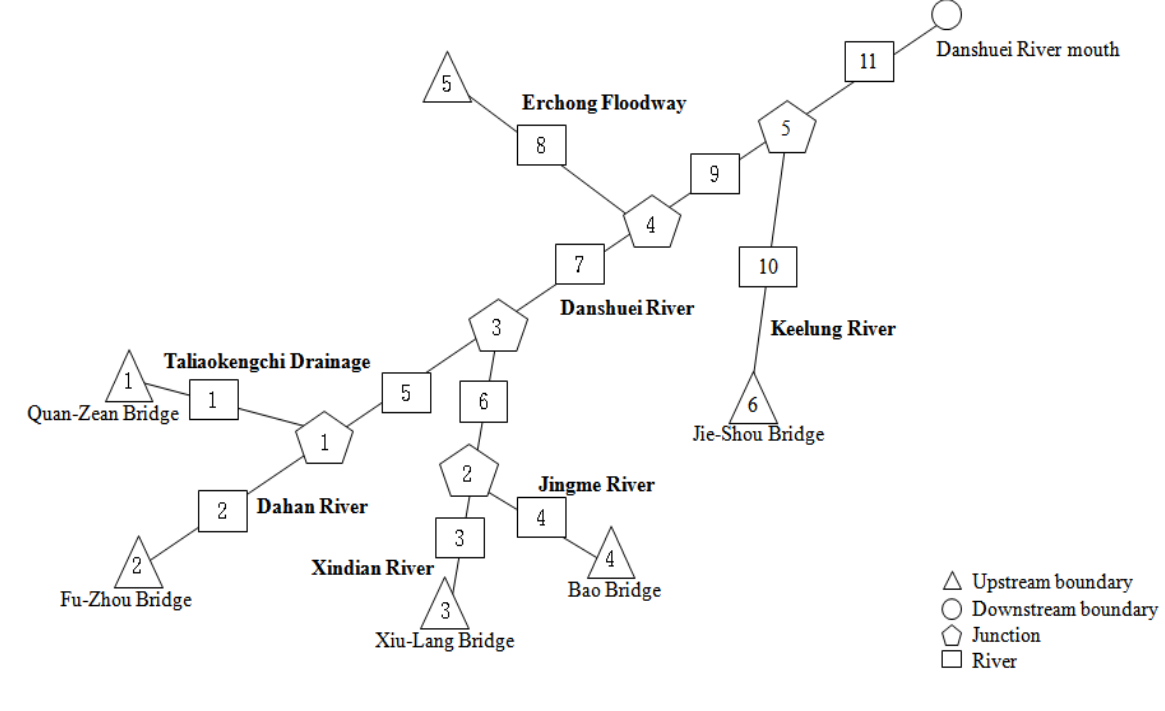
Figure 2. The Danshuei River system layout for the flood routing hydrodynamic model simulation and boundary